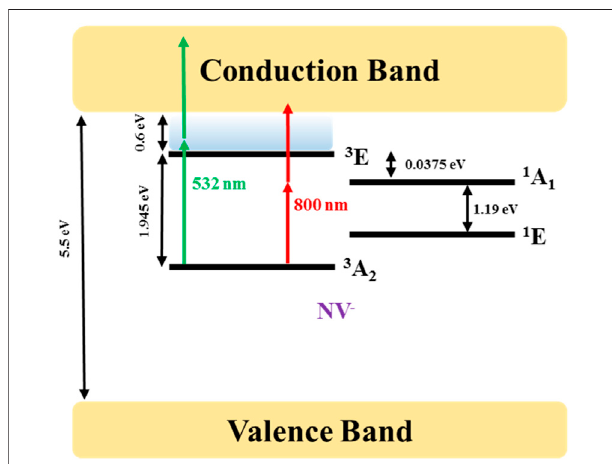
FIGURE6 | Energy levels of NV centers in thebandgap ofdiamond. The green and red arrow lines represent the possible transition using 532-nm excitation and 800-nm excitation,